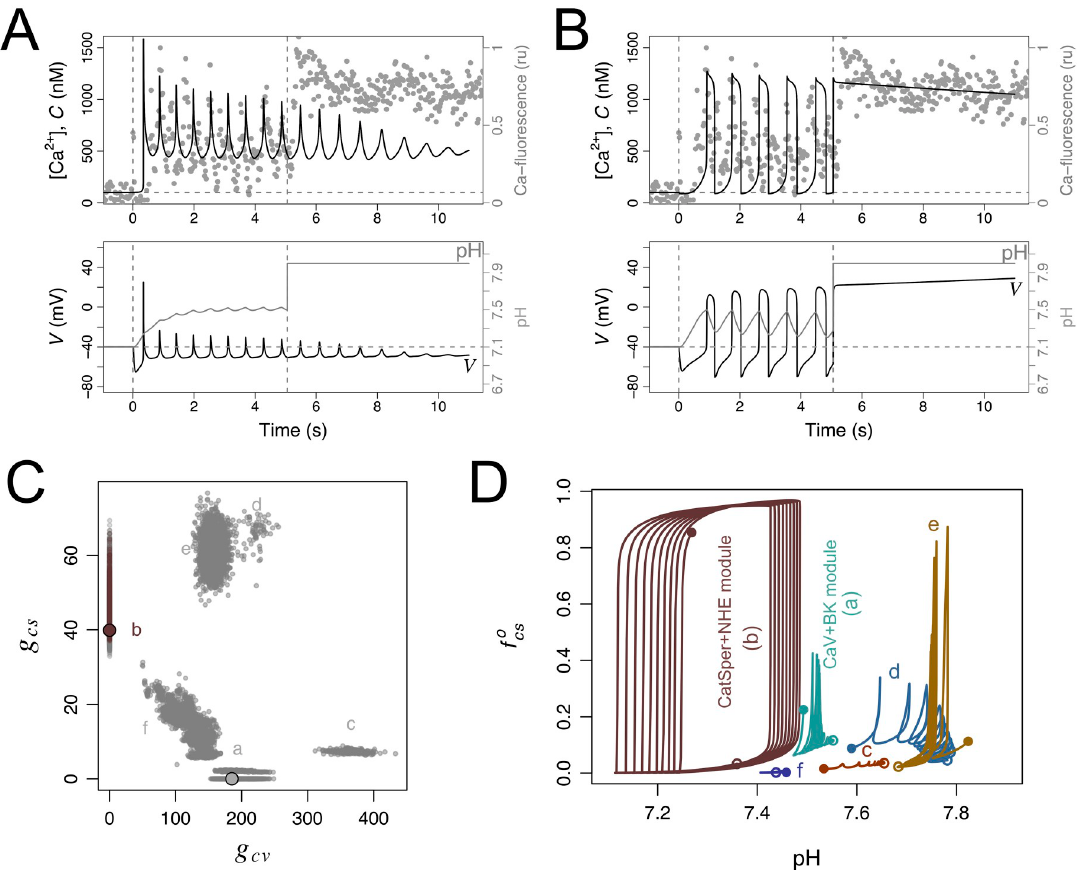
Fig 9. Responses to manipulation of pH i in the reference Ca V +BK and CatSper+NHE modules, and in mixed scenarios. In A and B, the graphs show the numerical solutions of the indicated variables under the reference parameters of the Ca V +BK (as in Fig 4) and the CatSper+NHE (as in Fig 6) modules. In both cases, the normal response to SAP release at time 0 s (vertical dashed line) develops until it is perturbed by an artificial raise in pH i (indicated by the second vertical dashed line) to a constant value maintained thereafter. Variables representing pH i and NHE in the model were coupled to those of the Ca V +BK module with the same reference parameters used in the CatSper module. The grey dots are a rescaled trace of the relative intensity of a Ca-sensitive fluorescent probe in S. purpuratus individual sperm cell bound to a coverslip obtained by adding first 100 nM Speract (vertical dashed line) and subsequently 10 mM NH 4 Cl (second vertical line). C) Parameter vectors projected onto the plane ( g cv , g cs ) (as in Fig 8A) were coloured according to predicted model responsiveness during identical pH i manipulation protocol: if alkalinisation results in sustained, slow decaying C dynamics the parameter set is representing according to the cluster’s colour, otherwise it is depicted in grey. D) Plot of the fraction of open CatSper channels f o vs pH i in the numerical solutions of the model parameterised under the reference CatSper+NHE module, the cs reference Ca V +BK module, and with the parameter vectors singled out from the clusters c, d, e and f illustrated in Fig 8. The trajectories are displayed for the interval 2-12 s to avoid transients. further characterised for being more acidic and with higher membrane potential than the basal state. The coexistence of two states is best seen in the bifurcation diagrams in the top graph of Fig 7. According to the CatSper+NHE module, a sufficiently strong perturbation of the mem- brane potential may force a switch from the lower basal steady state to the state characterised by higher [Ca 2+ ] , where it will remain (Fig 10B). This behaviour contrasts with any model i with a single resting stable state, such as the one with Ca +BK module, in which the rise in V membrane potential has, at best, transient effects on membrane potential or pH but not on i [Ca 2+ ] , as illustrated in (Fig 10B). As a corollary of these properties, the Ca 2+ -spike train will i always terminate in the basal level according to the Ca +BK module, while according to the V CatSper+NHE module, the [Ca 2+ ] may remain at high values after the spike trains vanish i